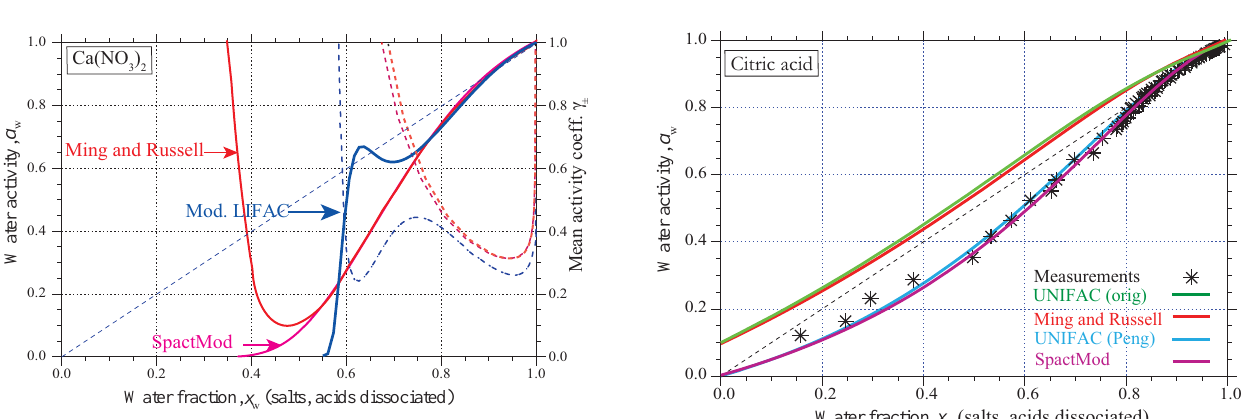
Figure 7. Comparison between experimental and calculated water activities ( a w ) in aqueous citric acid solutions as a function of water fraction ( x w ) at 298.15K. Experimental data are taken from Maffia and Meirelles